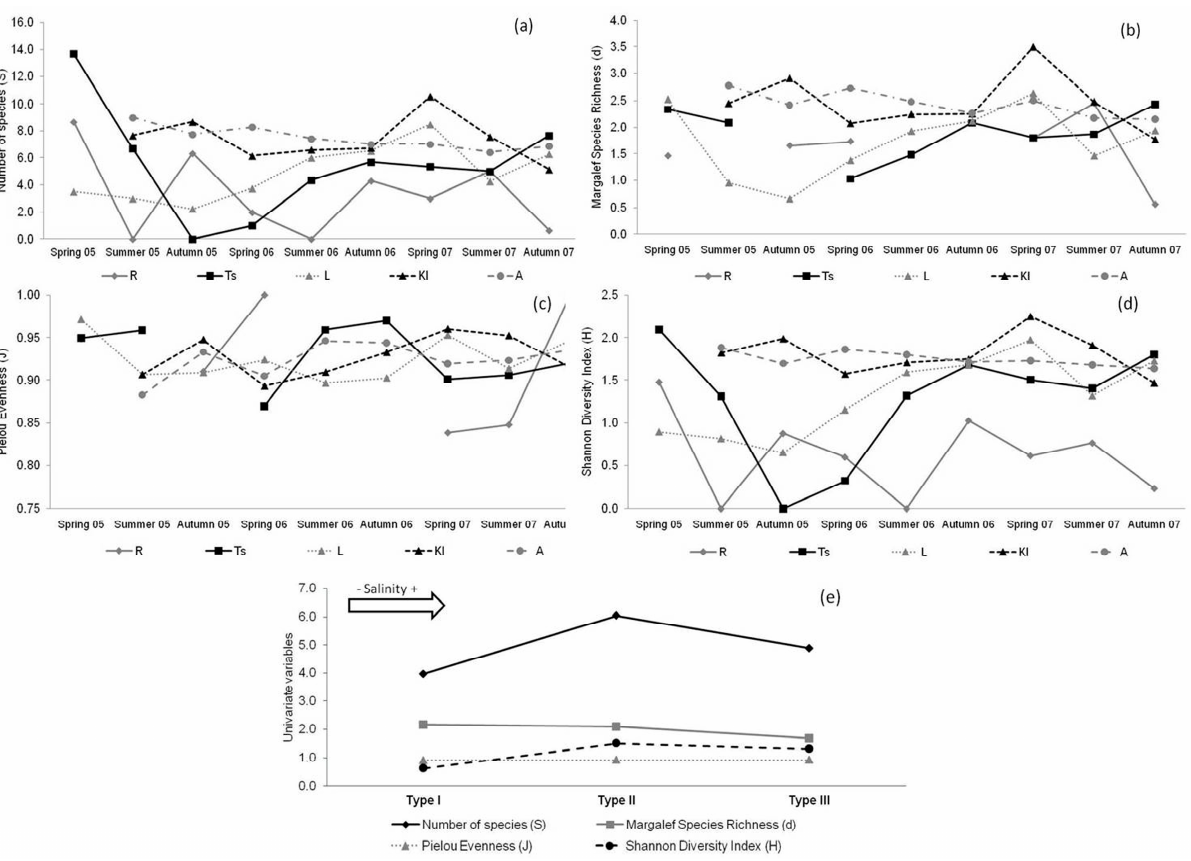
Figure 7. ( a – e ) The seasonal pattern of univariate variables of: ( a ) Number of species (S); ( b ) Margalef Species Richness (d); ( c ) Pielou Evenness (J); ( d ) Shannon Diversity Index (H) calculated from spring 2005 to autumn 2007 in each lagoon and ( e ) mean values of the univariate variables during the whole monitoring period in lagoon types of Western Greece.